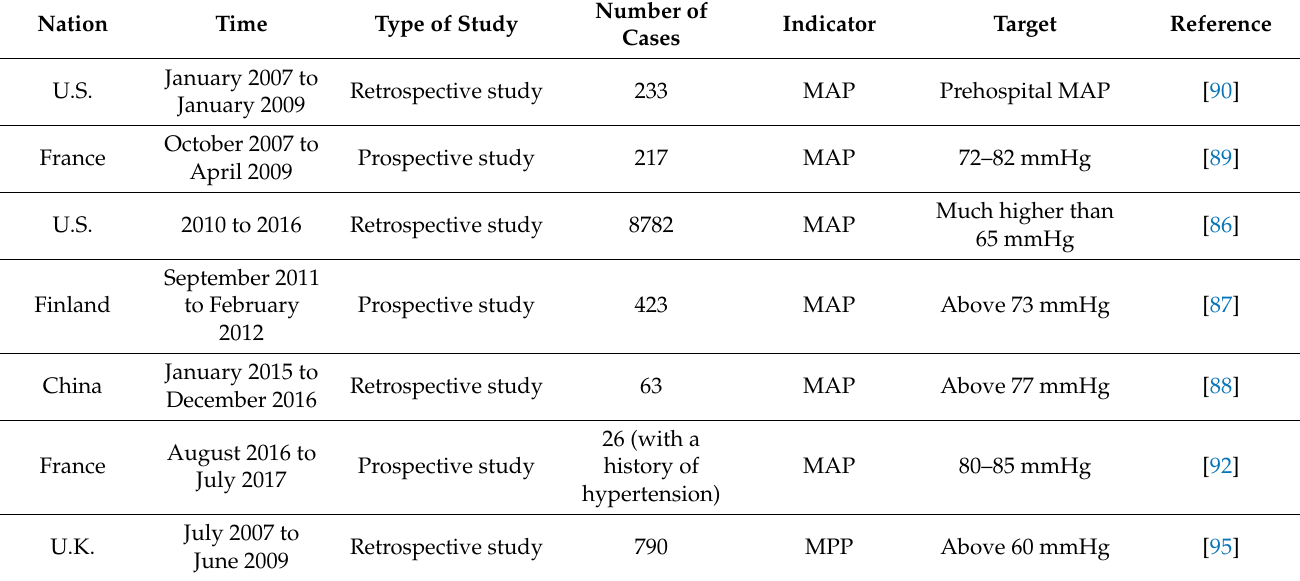
Table 2. Recommendations for sepsis blood pressure targets by